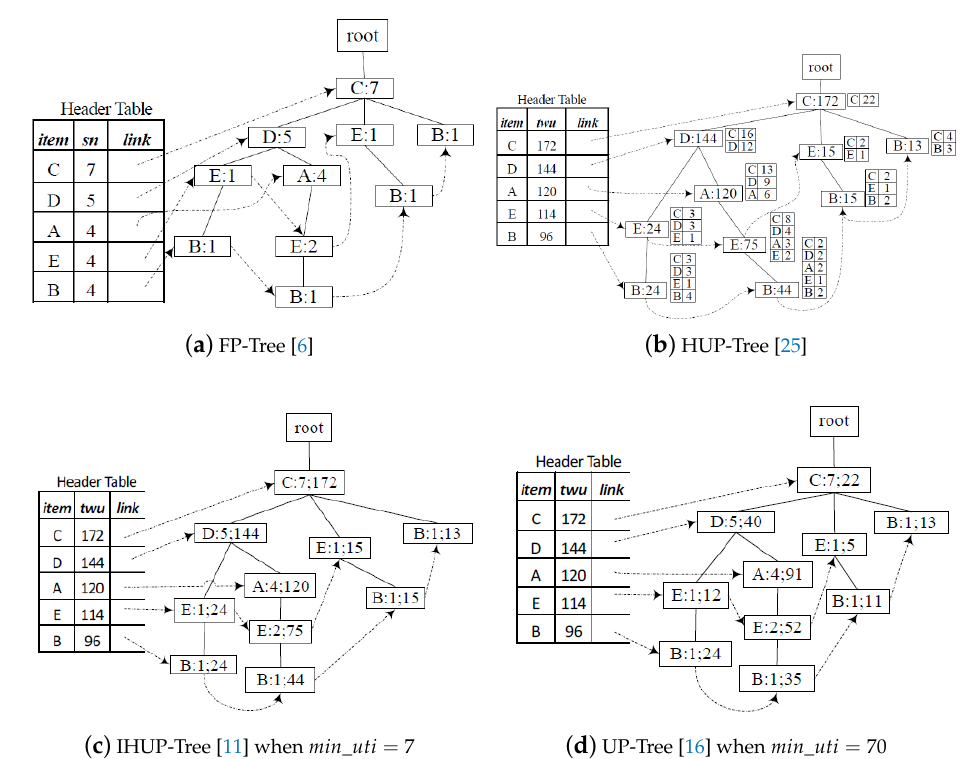
Figure 5. Example tree structures based on toy data in Tables 1 and 2.